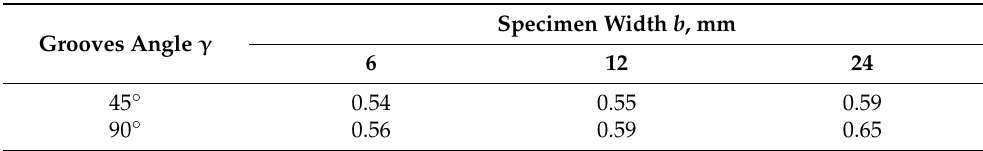
Table A1. Exponent n value determined by fitting of simulations data for different grooves angles and specimen